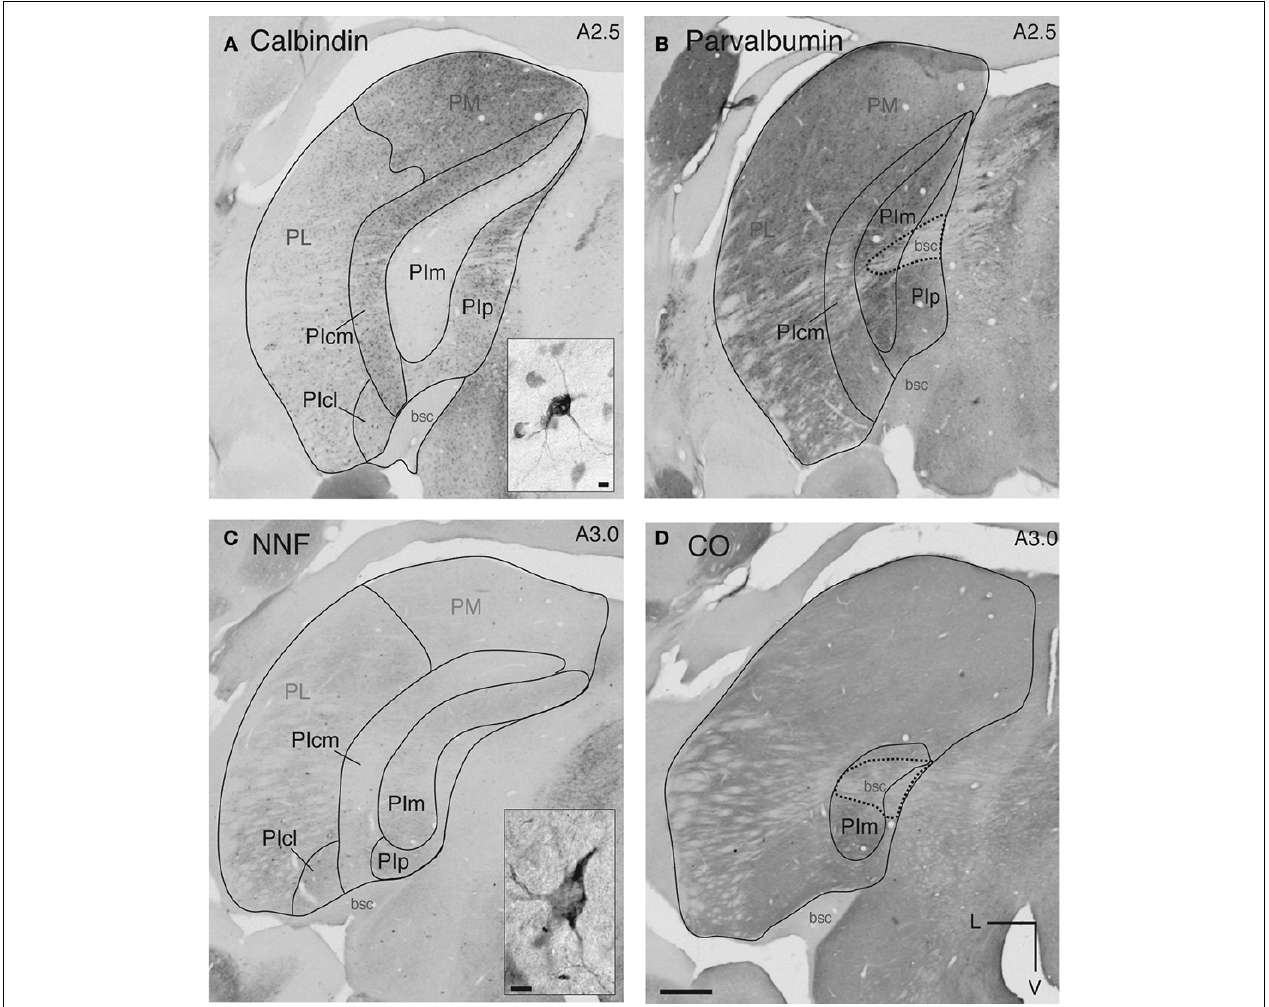
FIGURE 1 | Immunohistochemical and histological staining of the marmoset pulvinar nucleus enables demarcation of subnuclei. Coronal sections at a similar A-P level ( A,B : A 2.5 mm and C,D : A 3.0 mm) of the left hemisphere pulvinar nucleus ( A,B : CJ59, C,D : NM32) processed with different histological and immunohistochemical techniques. Demarcations have been included where it was possible to identify these with each stain. (A) Section of pulvinar nucleus reacted with the antibody to calbindin-D28k showing a lack of immunoreactivity in PIm surrounded laterally by a more intensely stained (cells and neuropil) PIcm. Medially located PIp has light neuropil and dark cells that are less densely stained than those of PIcm. Ventrolateral to PIcm is PIcl which has darker neuropil and sparse small dark cells. Lateral to PIcl and PIcm is PL, most of which stains lightly for neuropil and cells with the exception of the dorsomedial part that has slightly increased staining in cells. Inset: Also present in PL, PIcl and PIcm are large intensely stained cells, the majority residing ventrally. Dorsal to PI and PL lies PM with moderate staining of neuropil and small dark cells. (B) Section of pulvinar nucleus adjacent to (A) reacted for